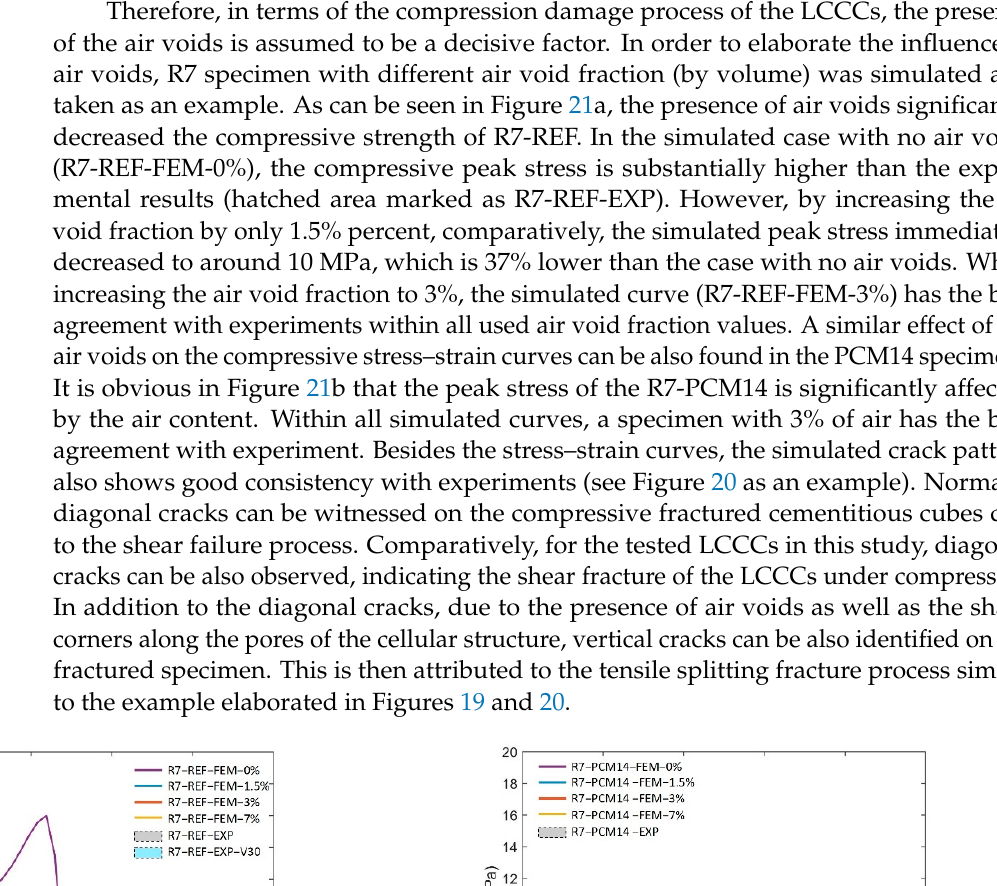
Figure 22. Simulated stress–strain curves of the LCCCs and 3% of air content are used for simula- tion.